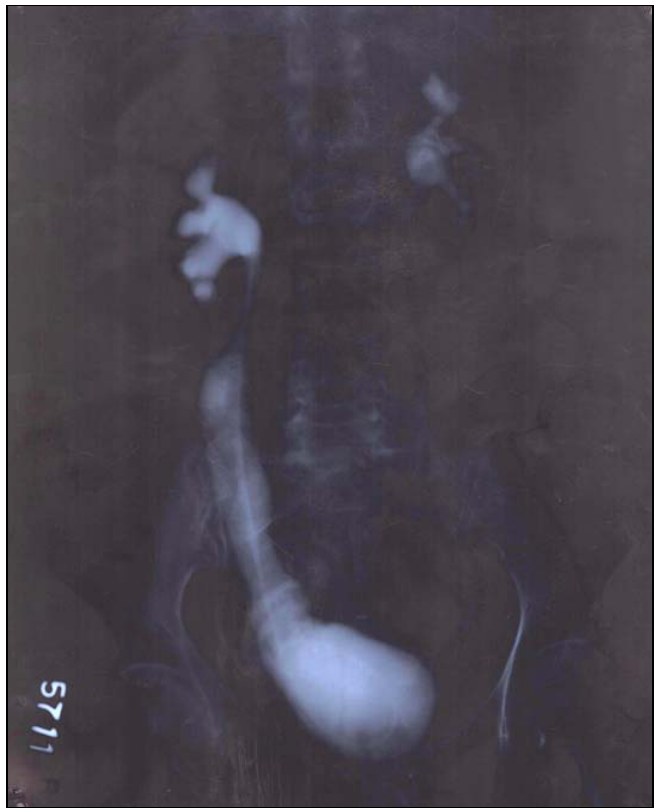
FIGURE 3 . Follow-up